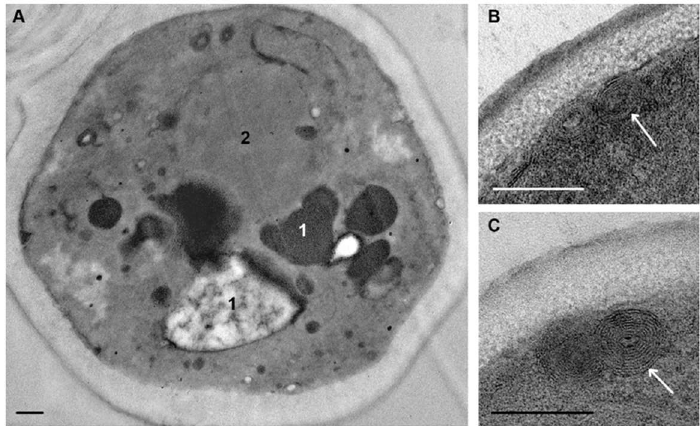
Figure 6. Changes in C. albicans cell ultrastructure after 30 min incubation with peptide (KFF)3K. ( A ) cell showing polymorphisms of the vacuole ( 1 ); 2 –nucleus. ( B , C ) multilayer structures (shown by arrows) on the border of the plasma membrane and the cell wall. ( A , C ) sections without contrasting. Scale bars correspond to 500 nm ( A ) and 200 nm.